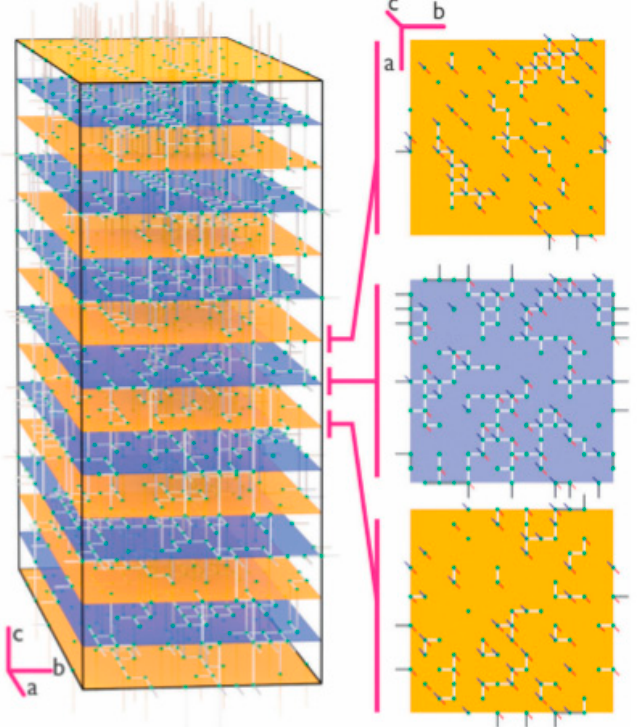
Figure 4. A schematic representation of diffusion pathways in lithium lanthanum titanate. Here the pathways in the ab directions are shown for every La poor and La rich layer. This is an example of how insights can be gained by the synergetic application of molecular dynamics with genetic algorithms. Reproduced by permission from the Owner Societies [59].